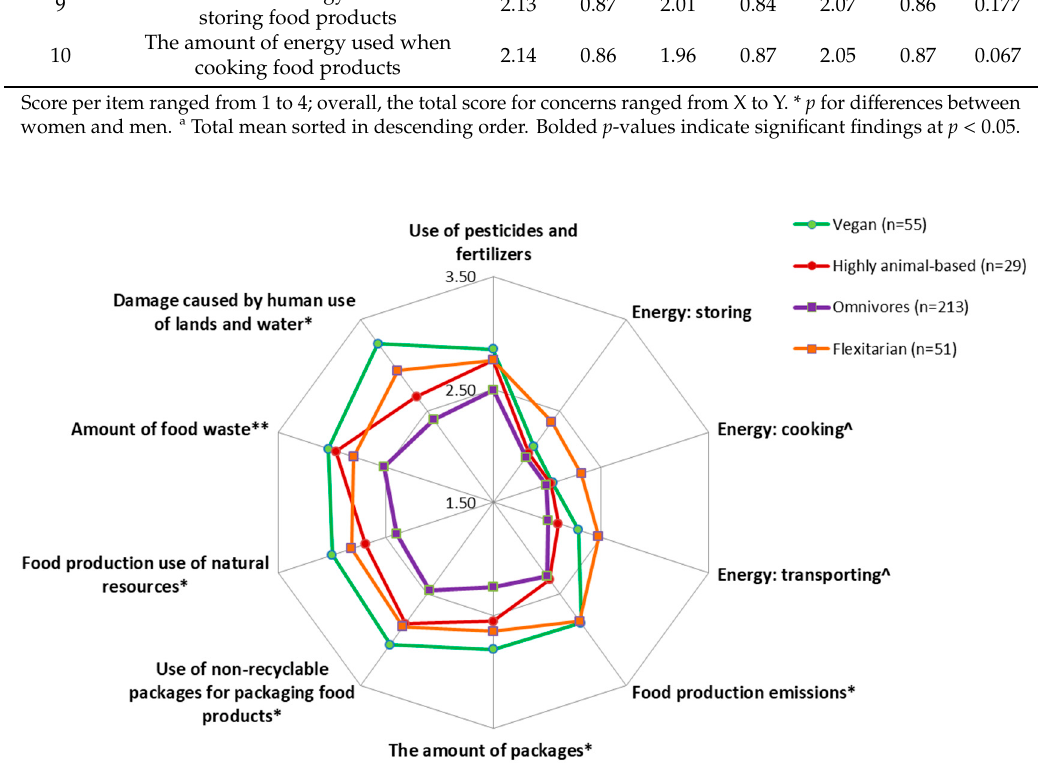
Figure 1. Food-related sustainability concerns by eating patterns. * Omnivores significantly differ from vegans and flexitarians, ** Omnivores significantly differ from vegans, ^ Omnivores significantly differ from flexitarians. All p -values < 0.05, corrected for Bonferroni multiple comparisons. Full results are in the appendix.